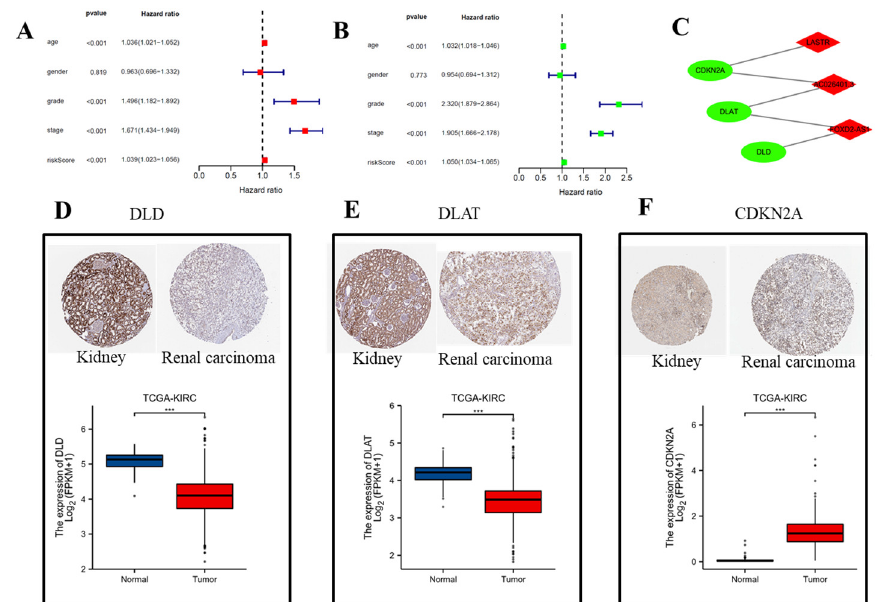
Figure 4. Independent prognostic analysis and validation of the effect of expression of real hub genes on transcriptional and translational level using TCGA database and The Human Protein Atlas database. ( A ) Univariate Cox with clinical variables and CRLRs. ( B ) Multivariate Cox with clinical variables and CRLRs. ( C ) Correlations between CRLRs and CRGs ( p < 0.05). ( D ) Comparison of DLD in TCGA-KIRC tumor and normal kidney tissue. ( E ) Comparison of DLAT in TCGA-KIRC tumor and normal kidney tissue. ( F ) Comparison of CDKNA2 in TCGA-KIRC tumor and normal kidney tissue. (*** p < 0.001).